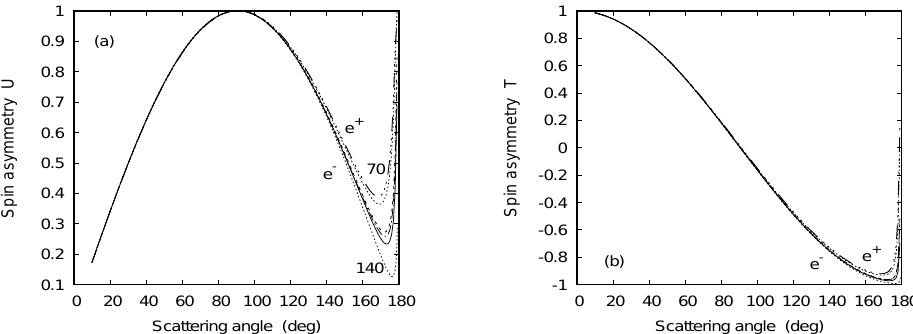
Figure 30. ( a ) Spin asymmetry U and ( b ) spin asymmetry T as functions of the scattering angle θ . Shown are results for 70 MeV electron scattering from Ni 58 ( − − −− ) , Pd 108 ( − · − · − ) , and Pt 196 (— ——), as well as for 70 MeV positron scattering from Ni 58 ( · · · · · · , upper line) and Pt 196 ( − · · ·−· · · − ) . Included are results for 140 MeV electron scattering from Pt 196 ( · · · · · · , lower